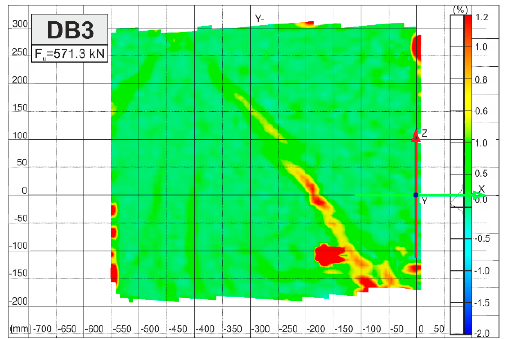
Figure 15. Contours of principal strains at peak load.